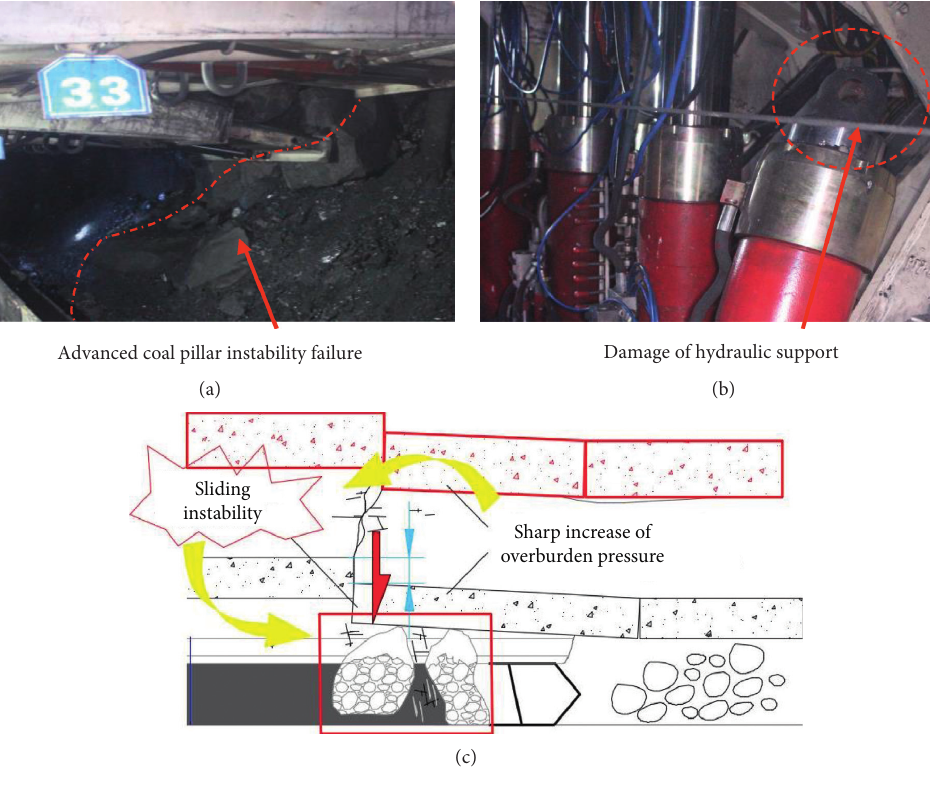
Figure 3: The in situ investigation photos and schematic diagram of a serious accident. (a) Advanced coal pillar instability failure; (b) damage of hydraulic support; (c) schematic diagram of a serious accident. Table 1: The ratio for different similarity model